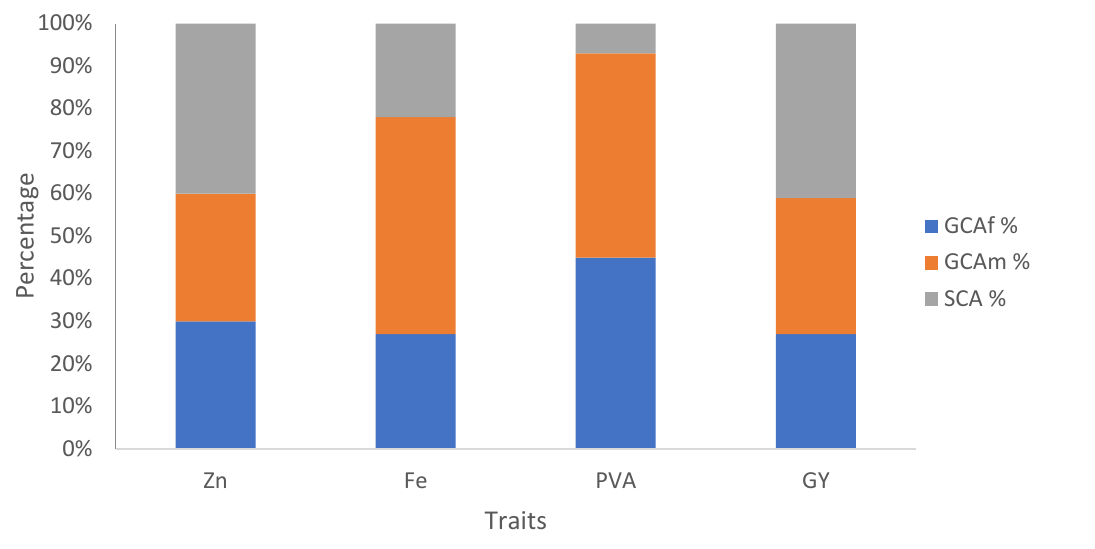
GY: grain yield, SCA: specific combining ability, GCAm: general combing ability male, GCAf: gen- eral combining ability female, PVA: provitamin A. Figure 1. The relative contribution of GCA of 24 inbred lines and SCA to the inheritance of Fe, Zn and grain yield in 96 F1 hybrids evaluated across environments.